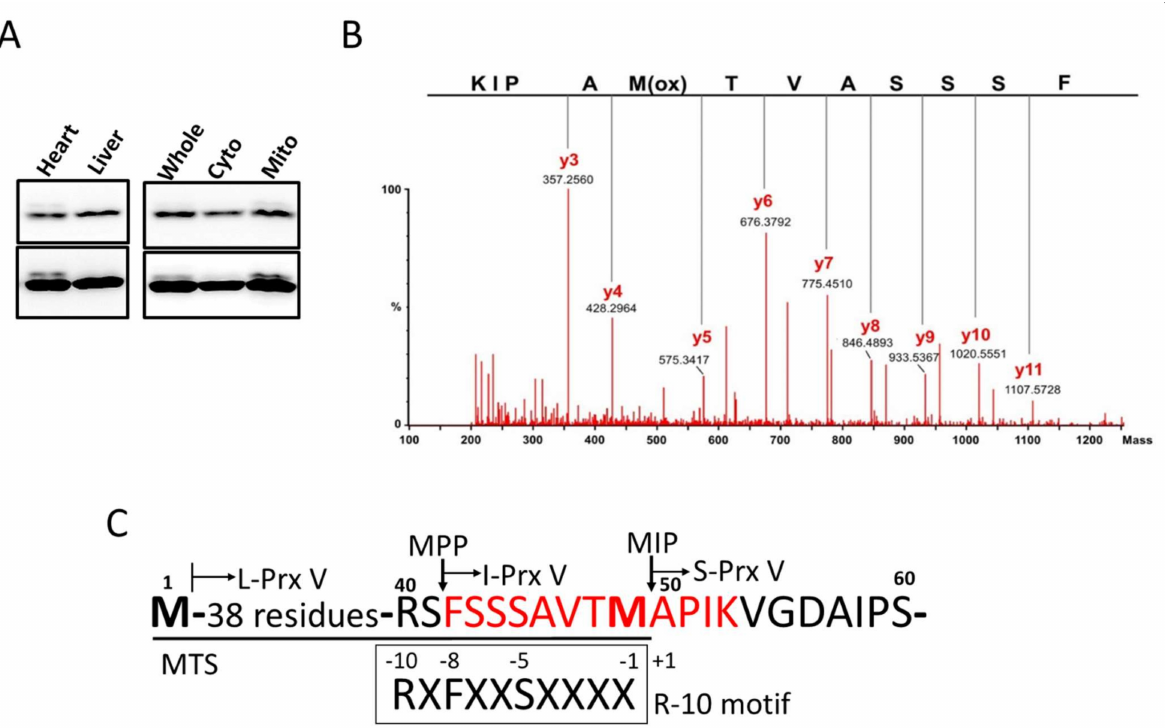
Figure 1. Detection of I-Prx V in mouse heart homogenate and its N-terminal amino acid sequence determined by mass spectrometry. ( A ) Mice heart and liver homogenates (left panel) and whole lysates, cytosolic, and mitochondrial fractions obtained after subcellular fractionation of heart homogenates (right panel) were subjected to immunoblot analysis with antibody to Prx V. Two different blot exposures are shown. ( B ) Collision-induced dissociation tandem mass spectrometry (MS/MS) spectrum of a peptide that is found in tryptic peptides derived from minor band (I-Prx V) but not in that derived from major band (S-Prx V). Amino acid sequence determined from the y ion series of the spectrum is indicated. ( C ) Scheme of the L-Prx V N-terminal amino acid sequence. Arrows indicate the MPP (mitochondrial processing peptidase) and MIP (mitochondrial intermediate peptidase cleavage sites. Methionines in bold type are encoded by the two in-frame AUGs used as translation-initiation sites. Amino acid sequence of I-Prx V tryptic peptide determined by mass spectrometry is highlighted in red type. MTS sequence is underlined, and R-10 motif is